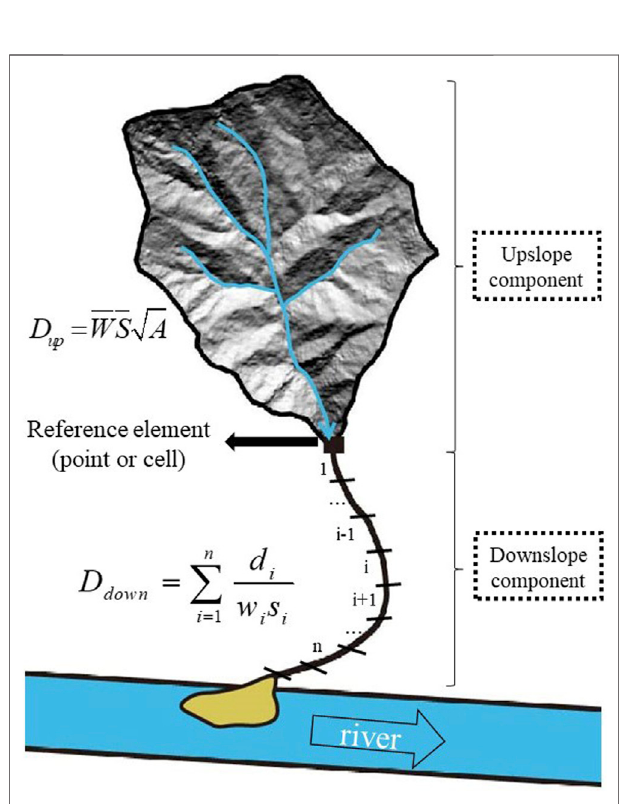
FIGURE 4 | De fi nition of the sediment connectivity index (IC; Borselli et al., 2008).